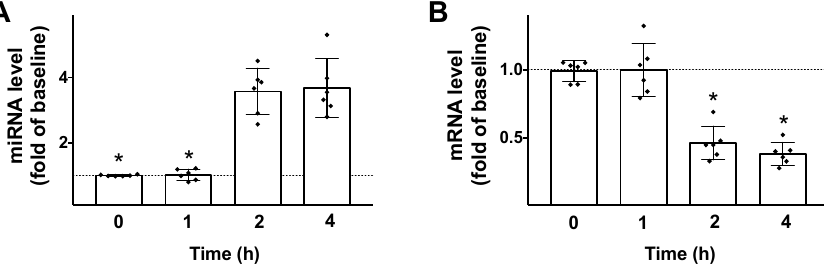
Figure 2. GLP-1 regulates miR-7 and β ARR1 transcription in pancreatic β cells. Stimulation of INS-1 β cells with GLP-1 (100 nM) induces an upregulation of miR-7 ( A ); and a downregulation of β ARR1 ( B ). Means ± S.E.M. are shown alongside actual values. * p < 0.05.